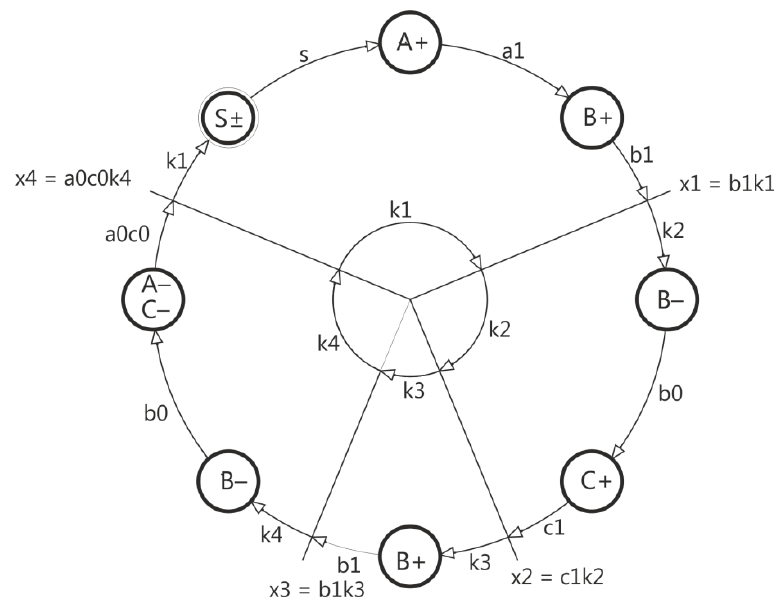
Figure 4. Division of the graph into states.